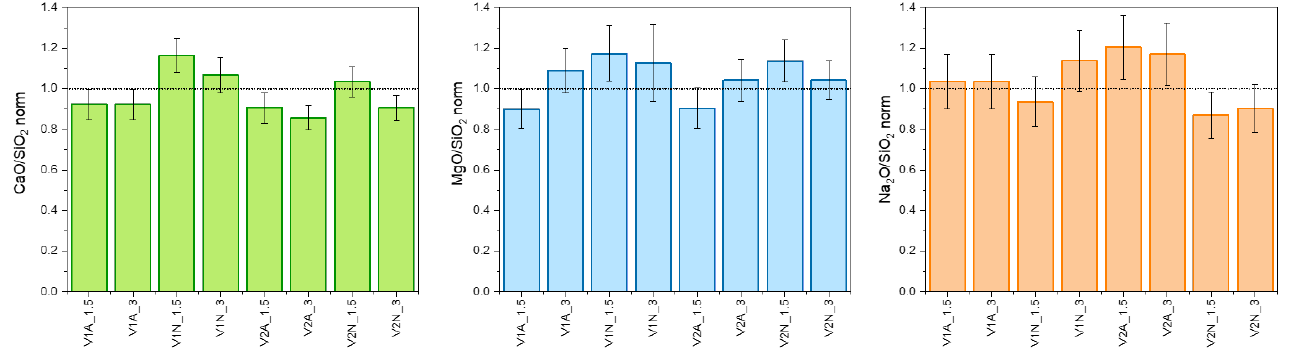
Figure 11. Normalized CaO/SiO 2 , MgO/SiO 2 , and Na 2 O/SiO 2 ratios inferred from EDS analysis on glass – ceramic coatings.